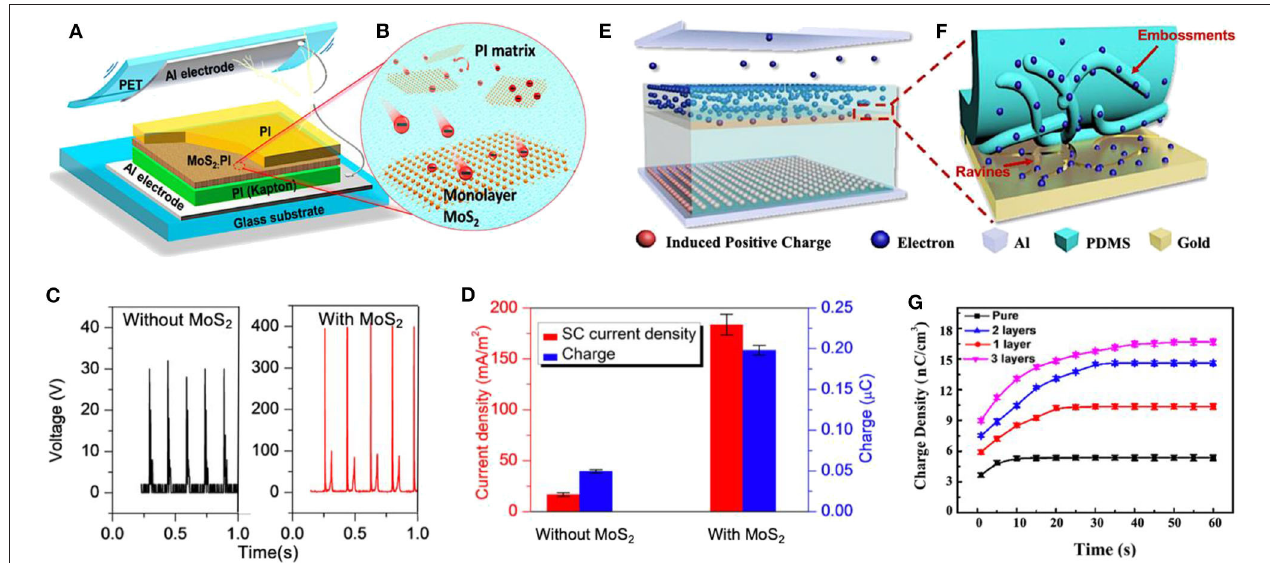
FIGURE 10 | Schematic diagrams and output performance of TENGs with dielectric monolayers. (A) Schematic diagram of a vertical contact-separation mode TENGs based on the MoS 2 -inserted PI layer. (B) Schematic views of the electron transfer from the PI layer to the MoS 2 monolayer. (C) Rectified open-circuit voltage of the TENGs without and with MoS 2 monolayer. (D) Short-circuit current density and the amount of charge generated during a press-release cycle for the TENGs with and without monolayer. Reprinted with permission from Wu et al. (2017). Copyright 2017 American Chemical Society. (E) Illustrations of electrons’ drift process in the TENG based on Au film. (F) Schematic diagram of electrons tunnel from PDMS to the Au film. (G) Transfer charge densities of TENGs. Reprinted with permission from Lai et al. (2018). Copyright 2018 American Chemical